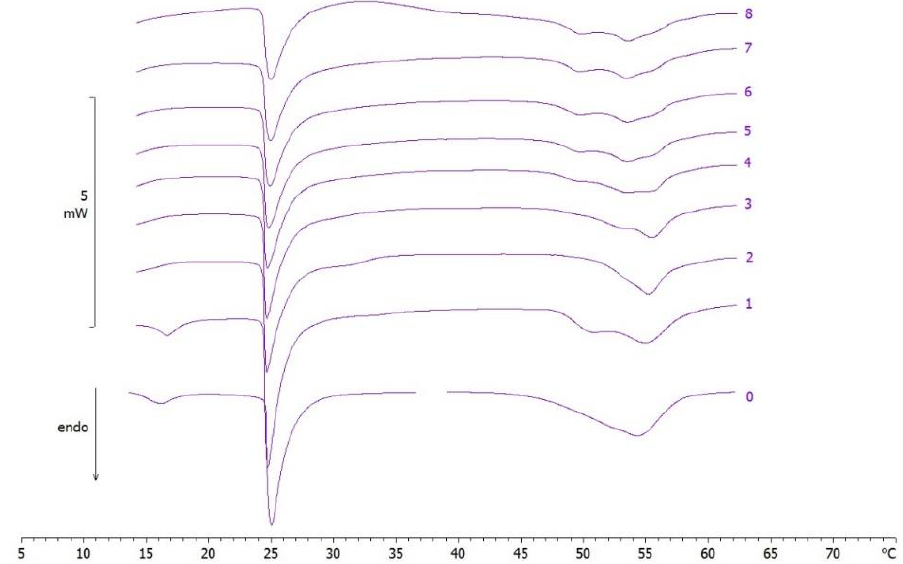
Figure 10. Calorimetric curves, in heating mode, of MLV put in contact with empty SLN, at pH 7.4, at increasing incubation time. The numbers on the right side of the curves refer to the calorimetric scans. The curves 0 refer to the samples before contact.